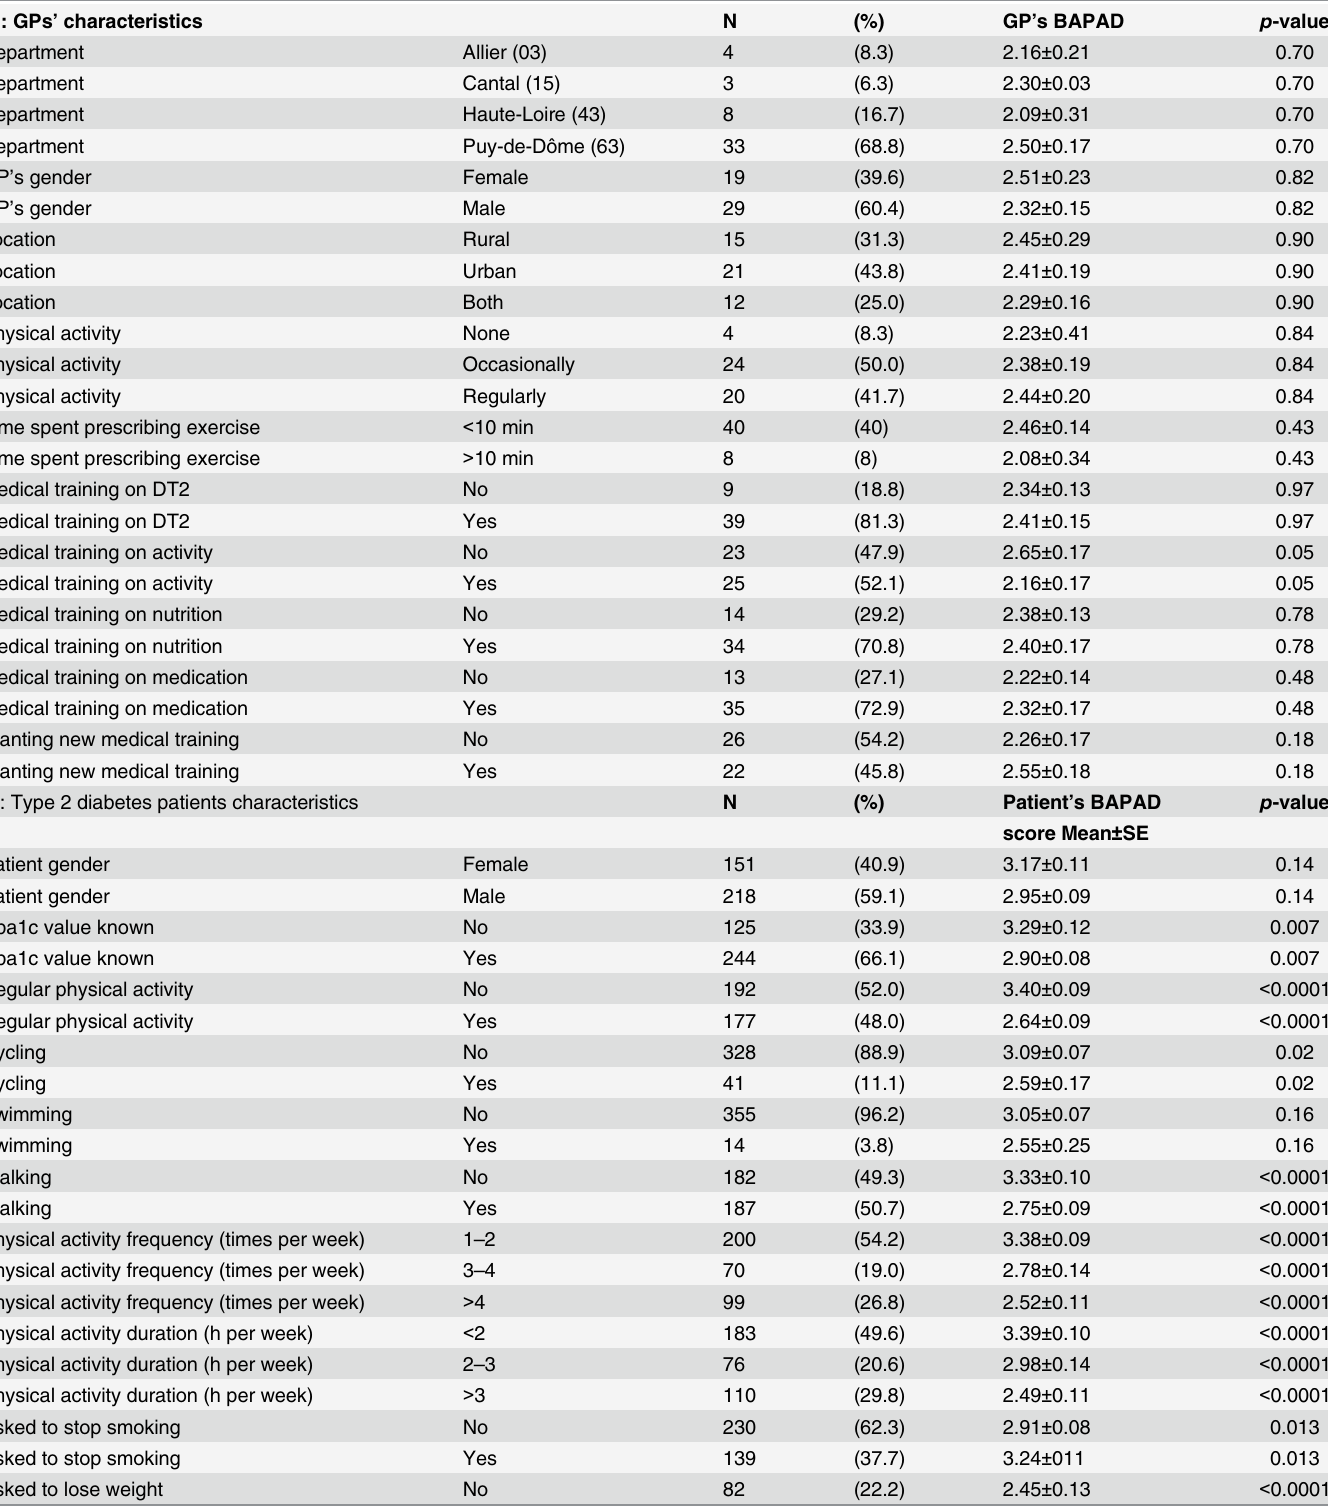
Table 2. GPs ’ BAPAD score regarding GPs ’ characteristics (A), type 2 diabetes patients ’ BAPAD score regarding patients ’ characteristics